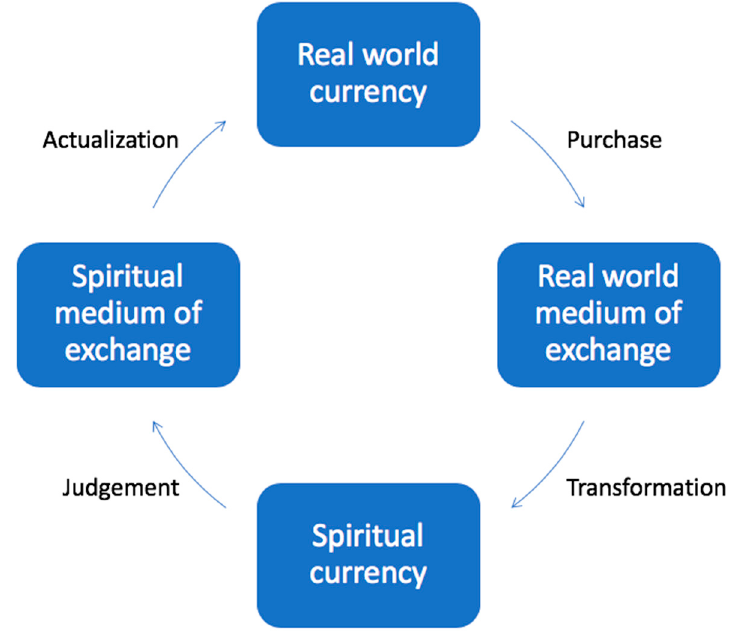
Figure 6. The cycle of occult exchange.